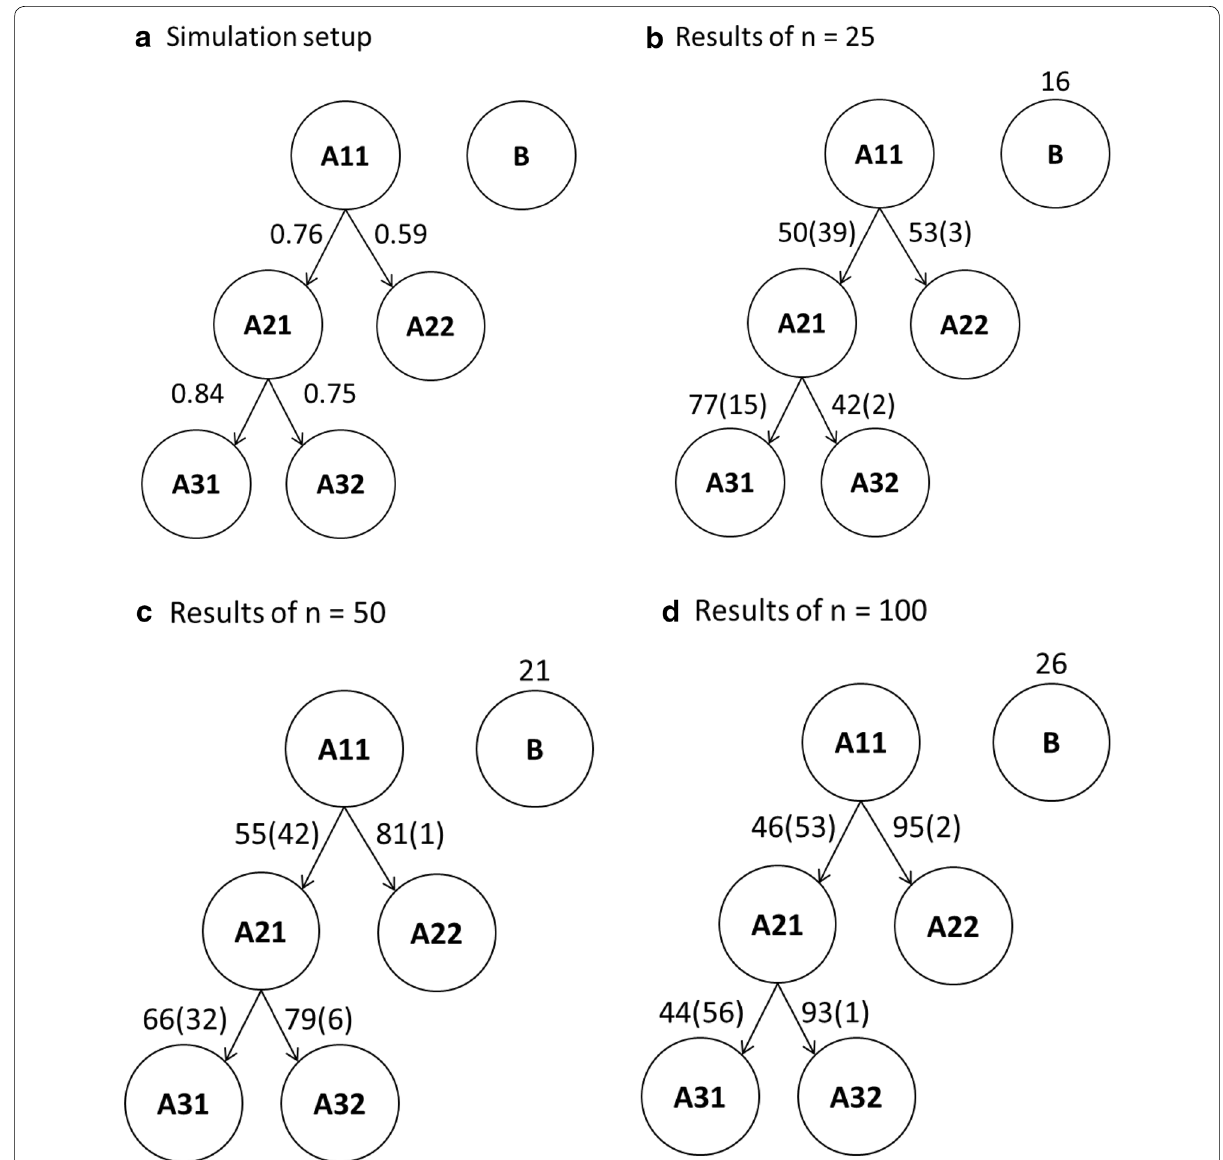
Fig. 3 Reconstruction of the a simulated network using sample size, b n the probabilities of the expression levels of the target genes actually determined by the expression levels of the source genes. The numbers next to the arrows in b – d are the numbers of arrows pointing in correct directions (outside of the parentheses) and the numbers of arrows pointing in incorrect directions (in the